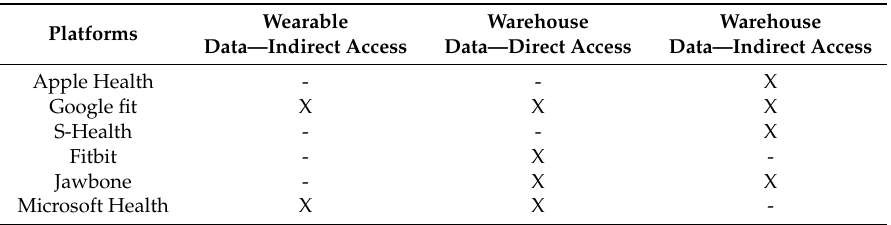
Table 2 . Data transfer options by platform summary. Table 2. Data transfer options by platform